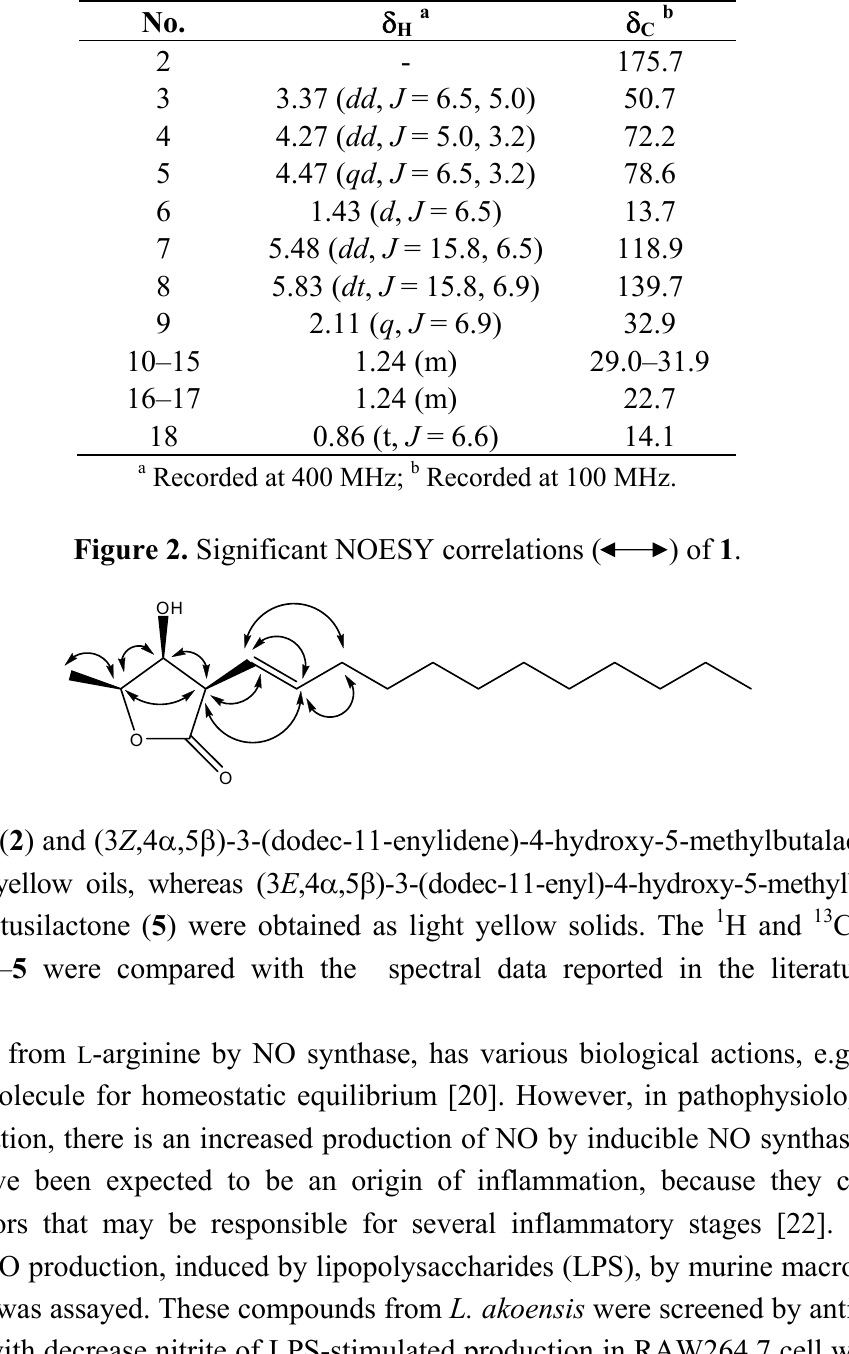
Table 1. NMR data (CDCl